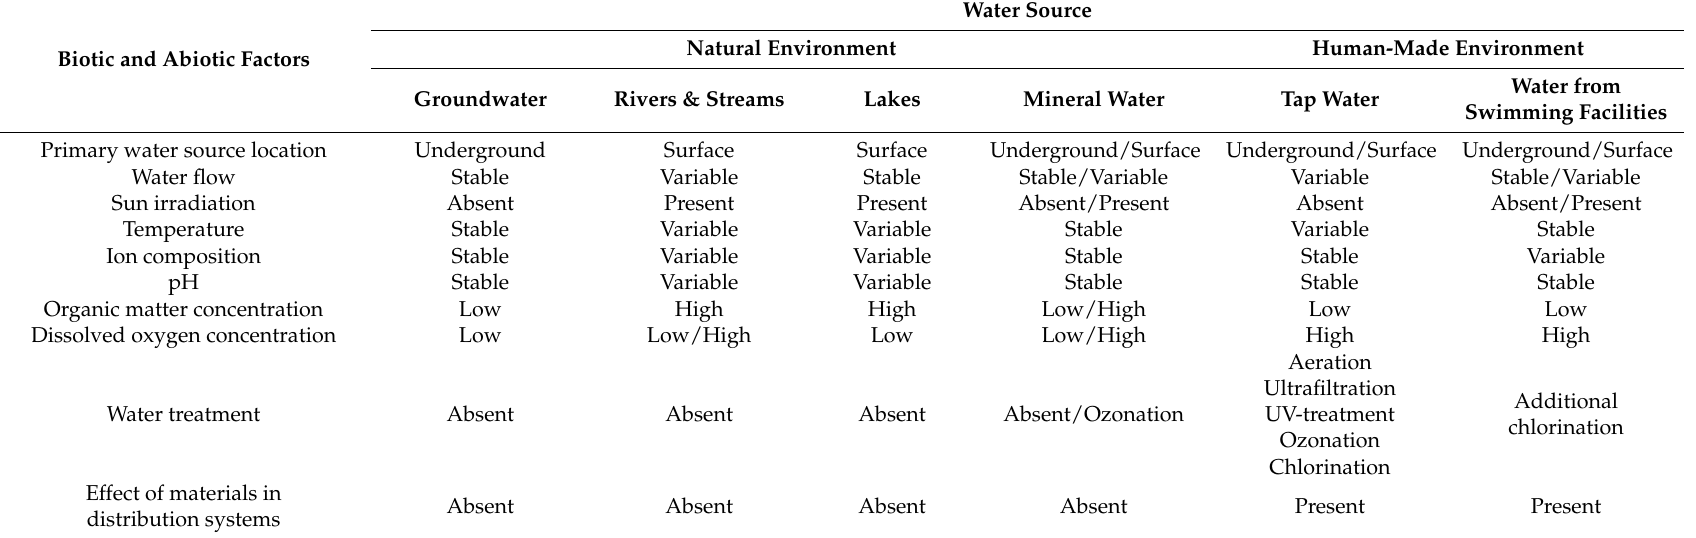
Table 1. Natural and anthropogenic biotic and abiotic factors, influencing microbial presence in different water